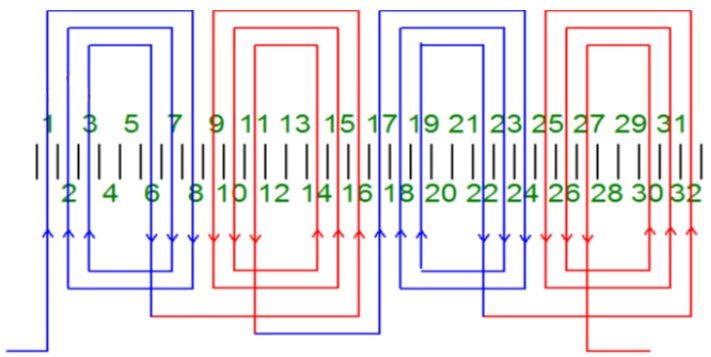
Figure 12. Harmonic components at 850 Hz under both measurement positions for generator operating at load variation in healthy and faulty case: ( a ) healthy case, ( b ) faulty case, ( c ) variation in faulty case for measurement in position 1, ( d ) variation in the faulty case for measurement in position 2.